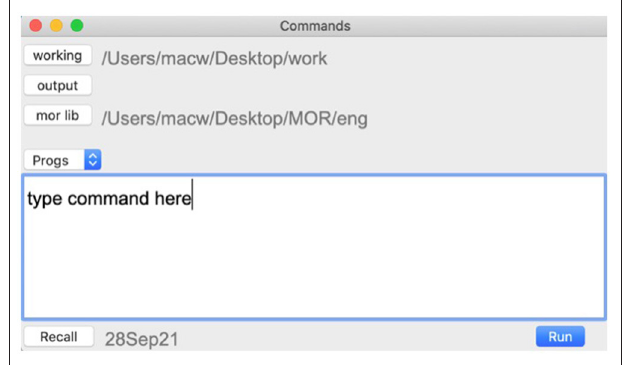
FIGURE 1 | CLAN commands